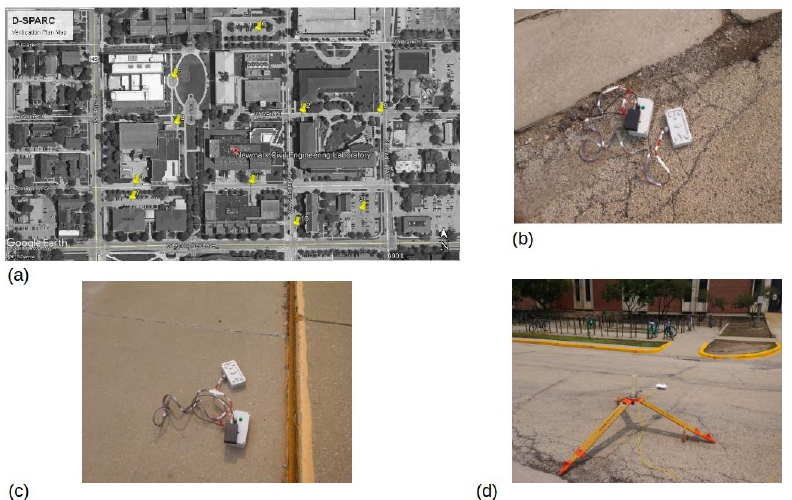
Figure 8. Field survey of albedo. ( a ) Selected locations within the University of Illinois campus; ( b ) using D-SPARC on an aged asphalt pavement ( c ) using D-SPARC on a concrete pavement; and ( d ) using an albedometer on an asphalt pavement.